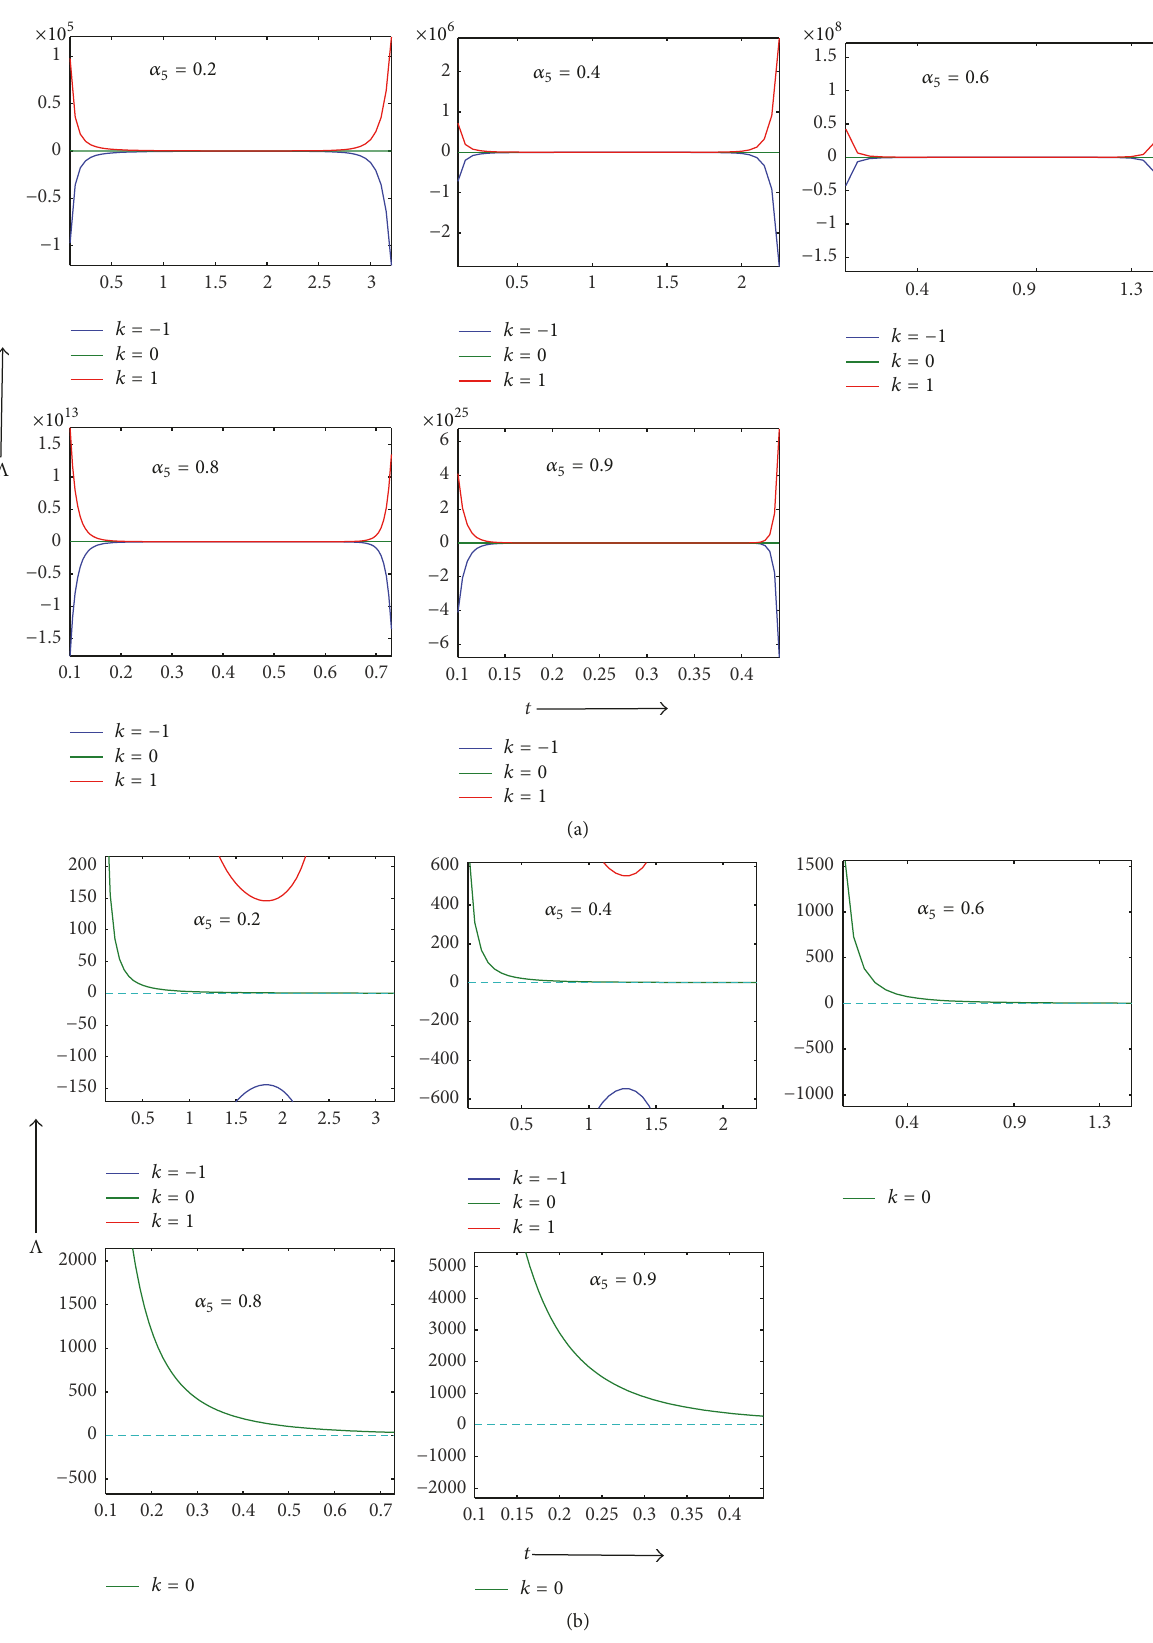
Figure 24: Variation of cosmological constant Λ against time for 𝛼 1 = 0.5 , 𝜔 = 1 , 𝑐 2 = 0.1 , and different 𝛼 5 . (b) shows the zooming of